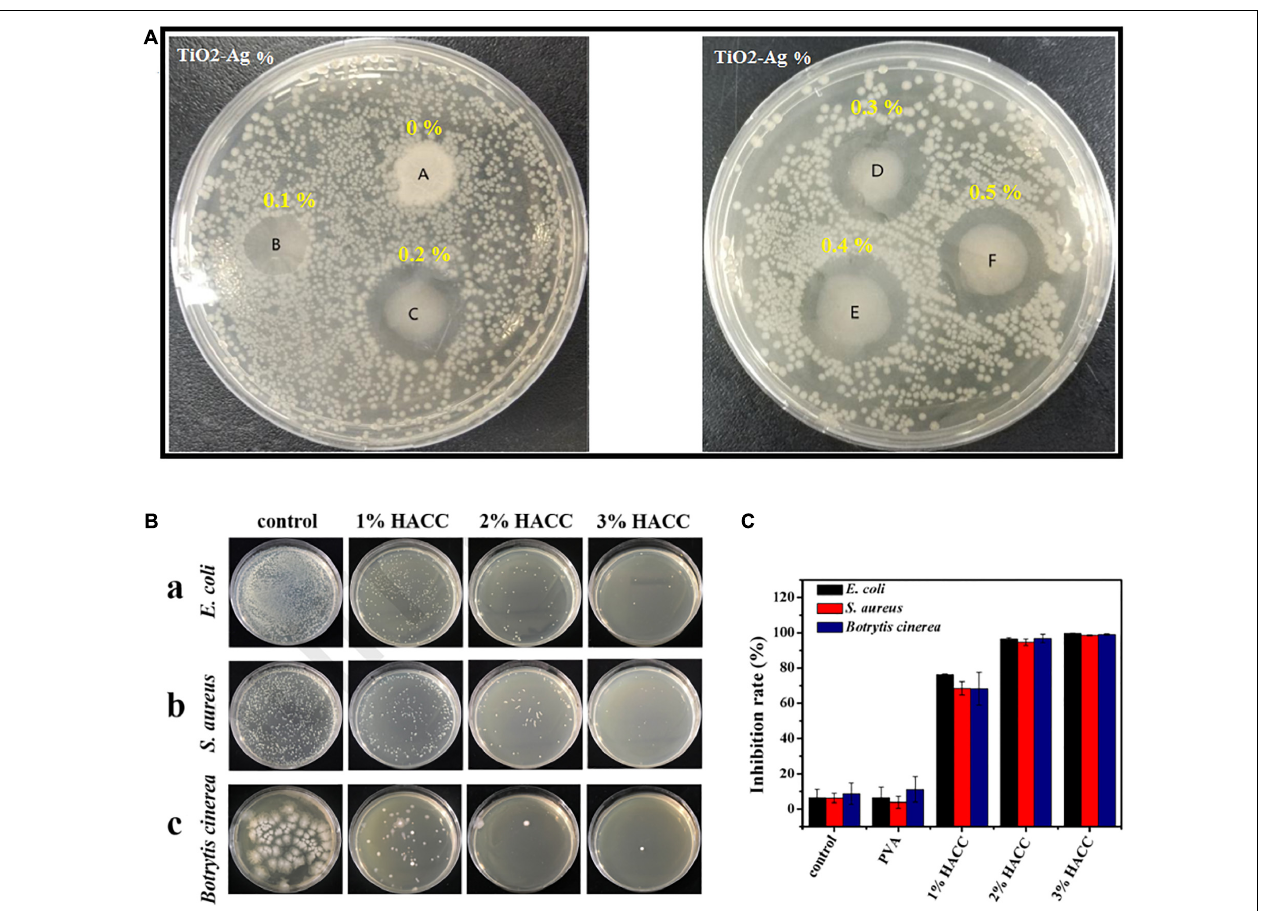
FIGURE 4 | (A) Inhibition zone test for fish gelatin–chitosan films containing different percentages of TiO 2 -Ag against E. coli [reproduced with permission from Lin et al. (2020)]. (B) The antibacterial impact of the chitosan/polyvinyl alcohol (HACC/PVA) composite films: (a) E. coli , (b) S. aureus , and (c) Botrytis cinerea . (C) The inhibition rate of different coatings for B. cinerea , S. aureus , and E. coli [reproduced with permission from Min et al.